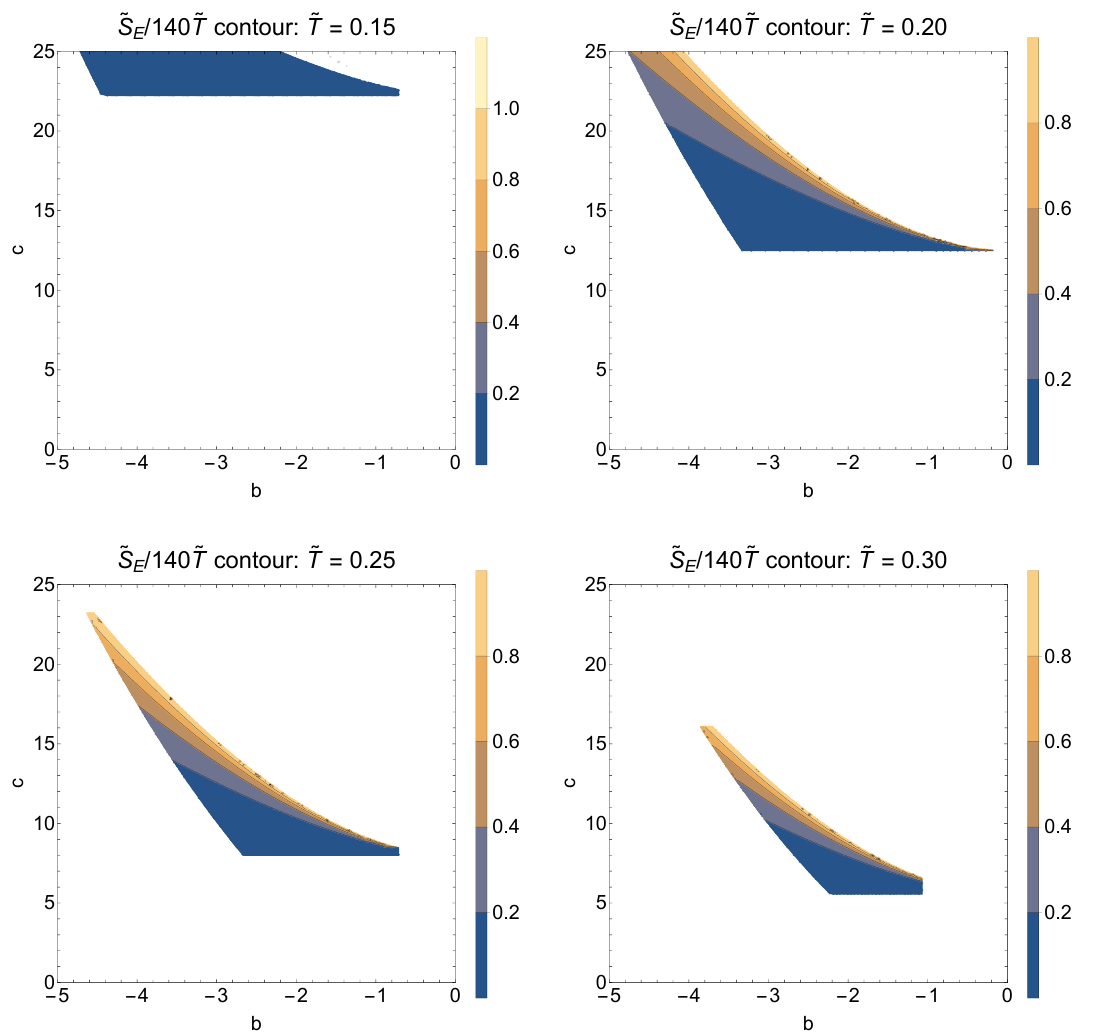
˜ ˜ S E / 140 T are shown in the ( b, c ) plane for smaller values of 140 ˜ T ≤ 1 , ˜ β/H ≥ ˜ S E /